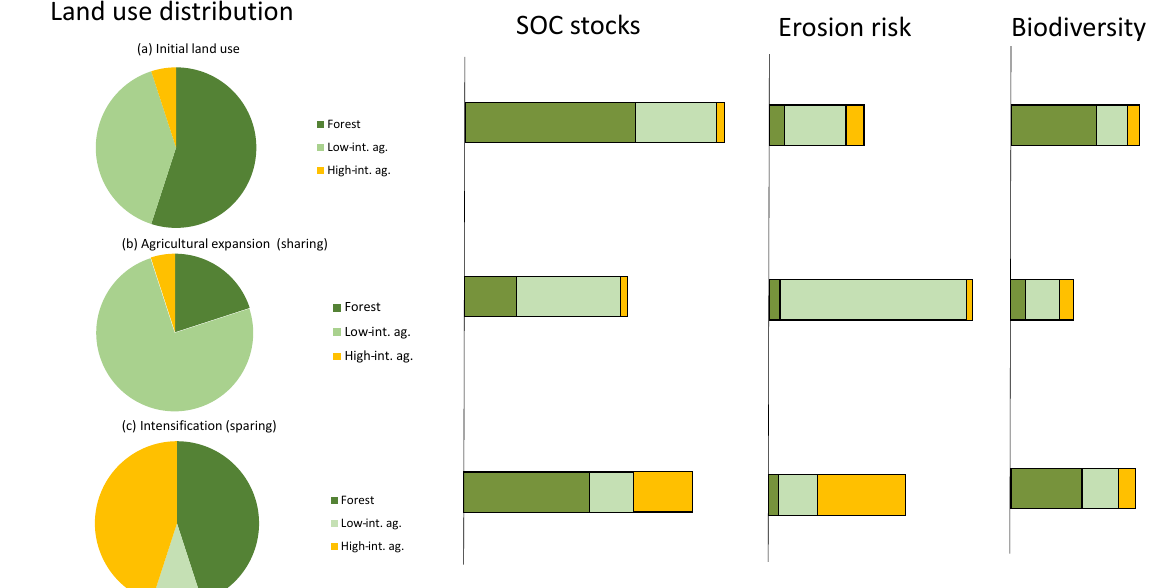
Figure 5. Semi-quantitative illustration of the effects of a significant increase in agricultural production through smart intensification (sparing land) vs. agricultural expansion (sharing land) on soil organic carbon stocks, the erosion risk and biodiversity. We assume that in a given area the required increase in agricultural production is such that, if yields are not increased, the entire area that is potentially suitable for agriculture (80% of the total area) has to be used for agriculture and that smart intensification would reduce the area needed to ca. 55% of the total area. The bar graphs give a semi-quantitative assessment, at the landscape scale, of the impact of these alternatives according to current scientific insights. Smart intensification is beneficial with respect to soil organic carbon storage because soil organic stocks under natural forest are much higher than under arable land (e.g. Poeplau et al., 2011). Smart intensification will reduce total soil erosion because less marginal (sloping) land needs to be taken into production (e.g. Van Rompaey et al., 2002). Finally, smart intensification is beneficial for biodiversity because more forest is preserved and the biodiversity of undisturbed forests is much higher than that of land used for agriculture (e.g. Phalan et al.,